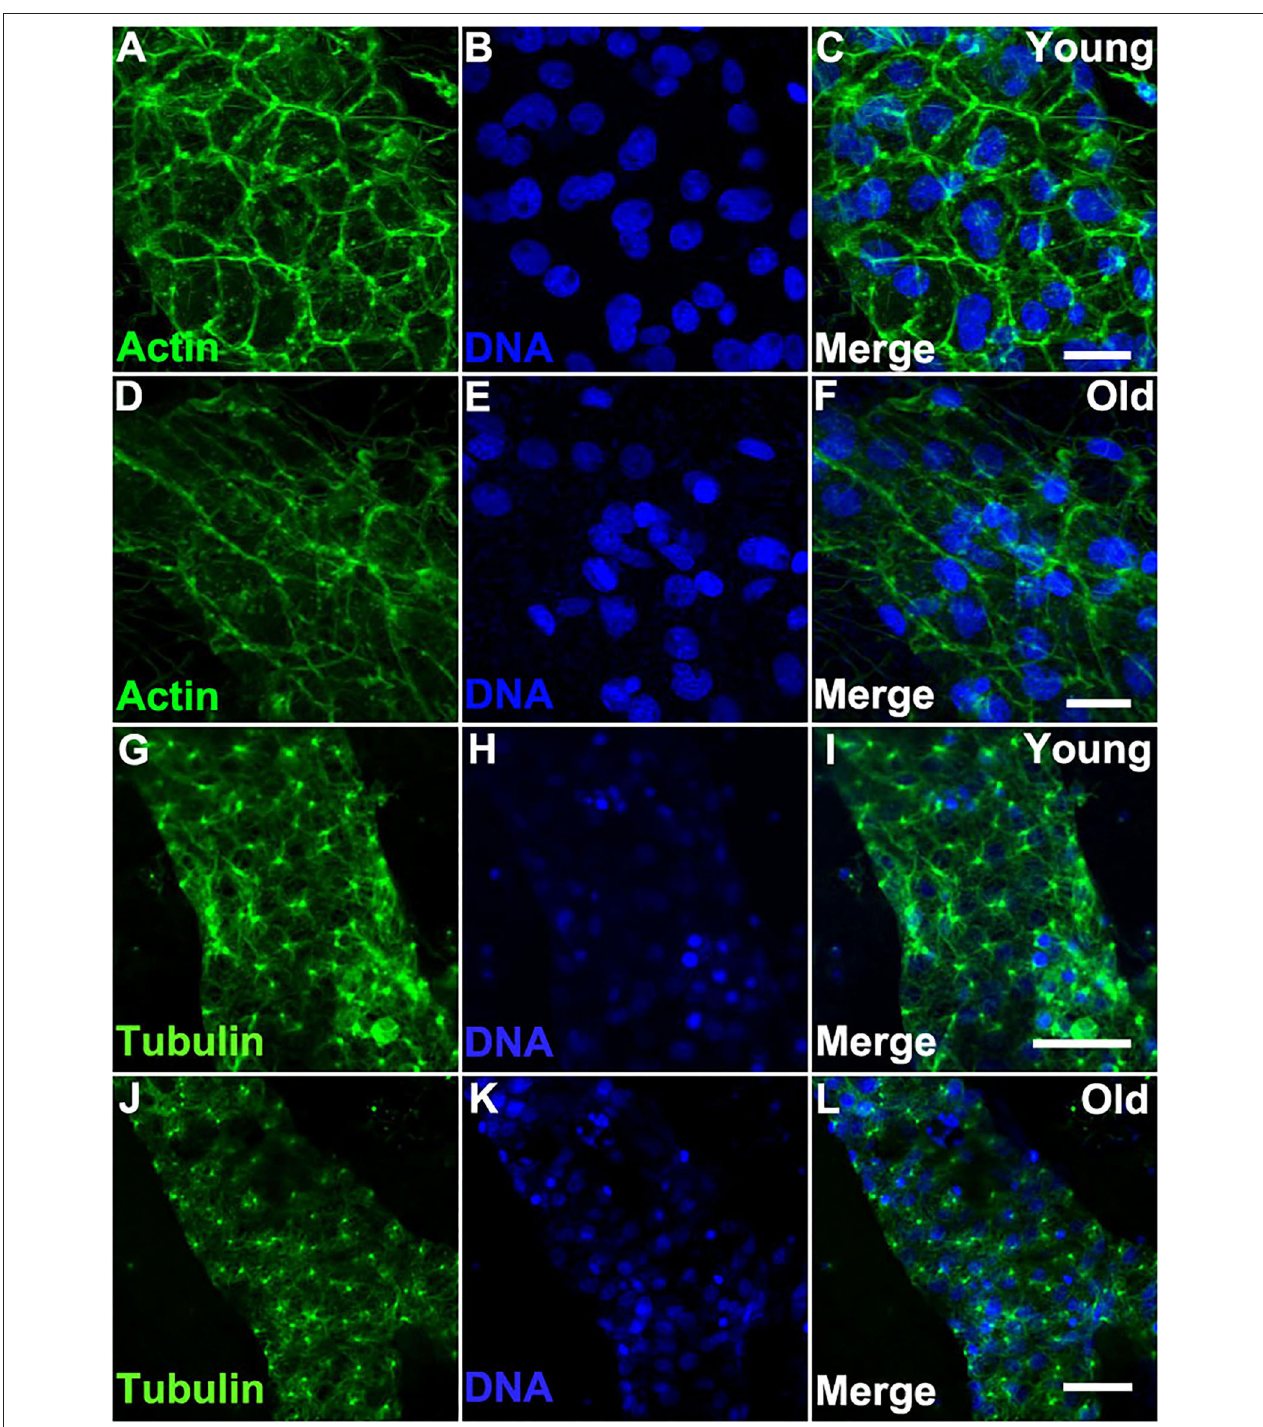
FIGURE 4 | Cytoskeleton changes in aged vascular cells. (A–C) Young vessels exhibit large polygonal round cells. (A) Representative images of the fluorescent actin stained with phalloidin-594 (green) in vessels of young Botryllus colonies which were counterstained with Hoechst 33342 to visualize the cell nuclei [ (B,C) merged]. (D–F) Old vessels exhibit stretched polygonal cells. (D) Representative images of the fluorescent actin stained with phalloidin-594 (green) in vessels of old Botryllus colonies which were counterstained with Hoechst 33342 to visualize the cell nuclei [ (E,F) merged]. (G,H) Young vessels exhibit abundant arrays of microtubules. (G) Representative fluorescent immunostaining of α -Tubulin vessels of young Botryllus colonies counterstained with Hoechst 33342 [ (H,I) merged]. (J–L) Old vessels exhibit less abundant arrays of microtubules. (J) Representative fluorescent immunostaining of α -Tubulin vessels of old Botryllus colonies counterstained with Hoechst 33342 [ (K,L) merged]. Scale bars: 50 µ